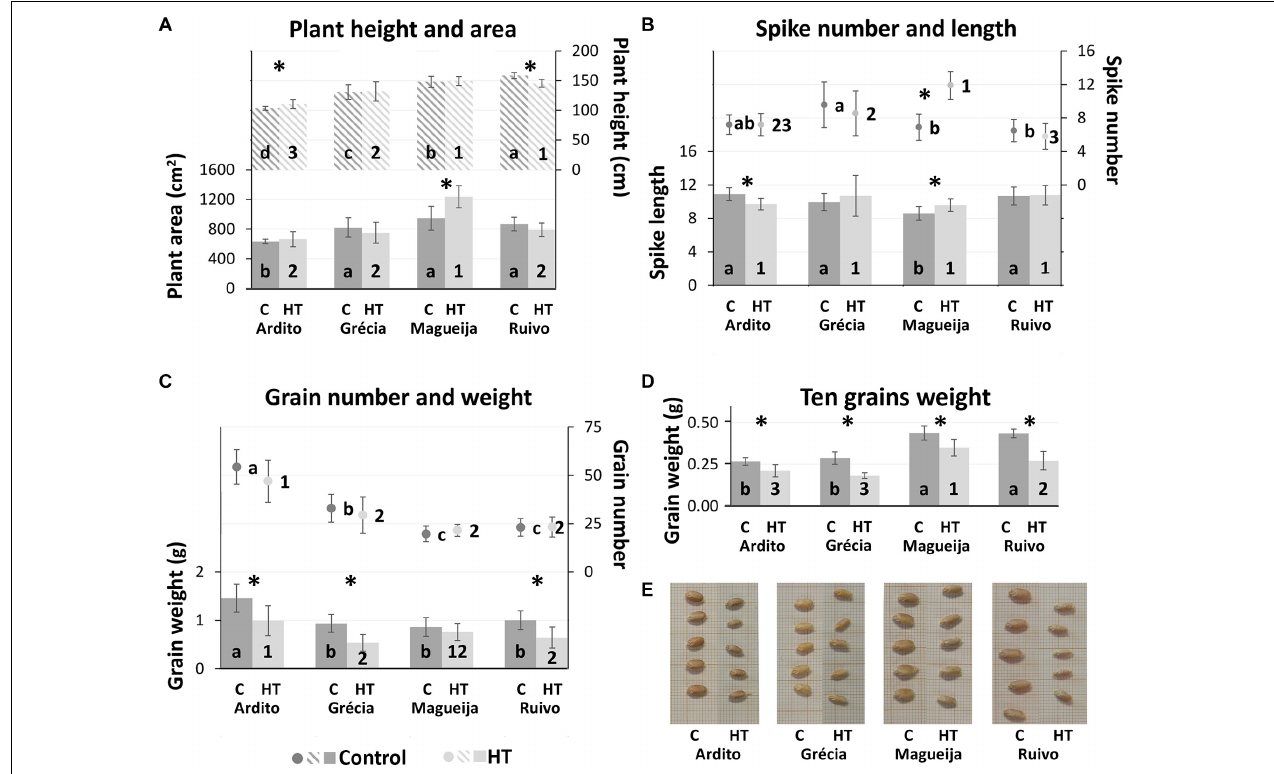
FIGURE 1 | Yield parameter evaluation. (A) plant height (listed columns) and area (full columns). (B) Number of spikes per plant (dots) and first spike length (columns). (C) First spike number of grains (dots) and grain weight (columns). (D) First spike 10-grain weight. Mean values of plants kept in control conditions (dark gray) and high temperature (HT) treatment (light gray) ± standard deviation (represented as bars). Different letters and numbers indicate ANOVA significant differences between varieties, in control and high-temperature (HT) conditions, respectively. * t-test statistical differences between control and treatment in